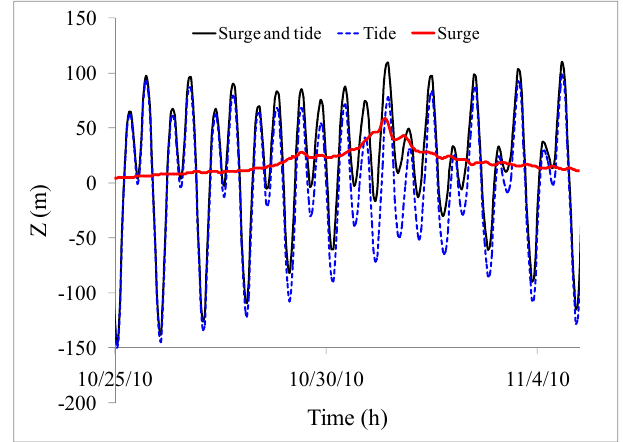
Figure 10. Time series of calculated only tides (“Tide”), surges coupled with tides (“Surge + Tide”), and surges with "Tide" extracted from “Surge + Tide” at Vung Tau station during the period of 25 October to 4 November